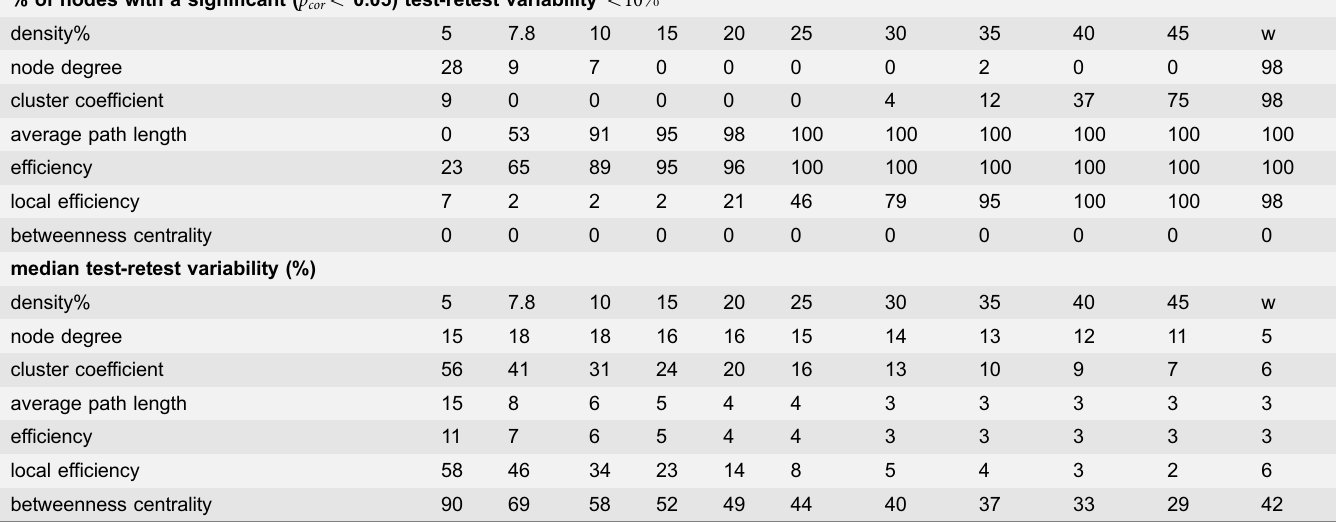
Table 3. The split-half case: the test-retest variability of local graph measures across densities. % of nodes with a significant ( p cor v 0.05) test-retest variability v 10 %